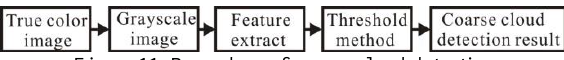
Figure 11. Procedure of coarse cloud detection